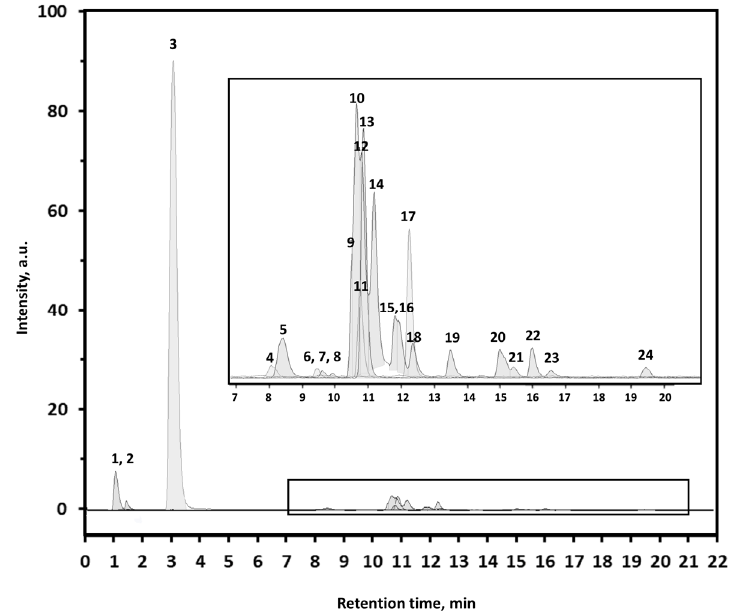
Figure 3. HPLC run of the crude reaction mixture of γ -irradiated N 2 O-saturated aqueous solutions containing 1.0 mM of methionine derivative 1 (peak 3) at natural pH at a dose of 800 Gy (dose rate of 46.7 Gy min −1 ); the consumption of 1 lead to the formation of 23 products; peaks 1 and 2 assigned to compounds 3 and 4 , respectively (cf. Scheme 6). Inset: expansion of the chromatogram between 7 and 21 min.